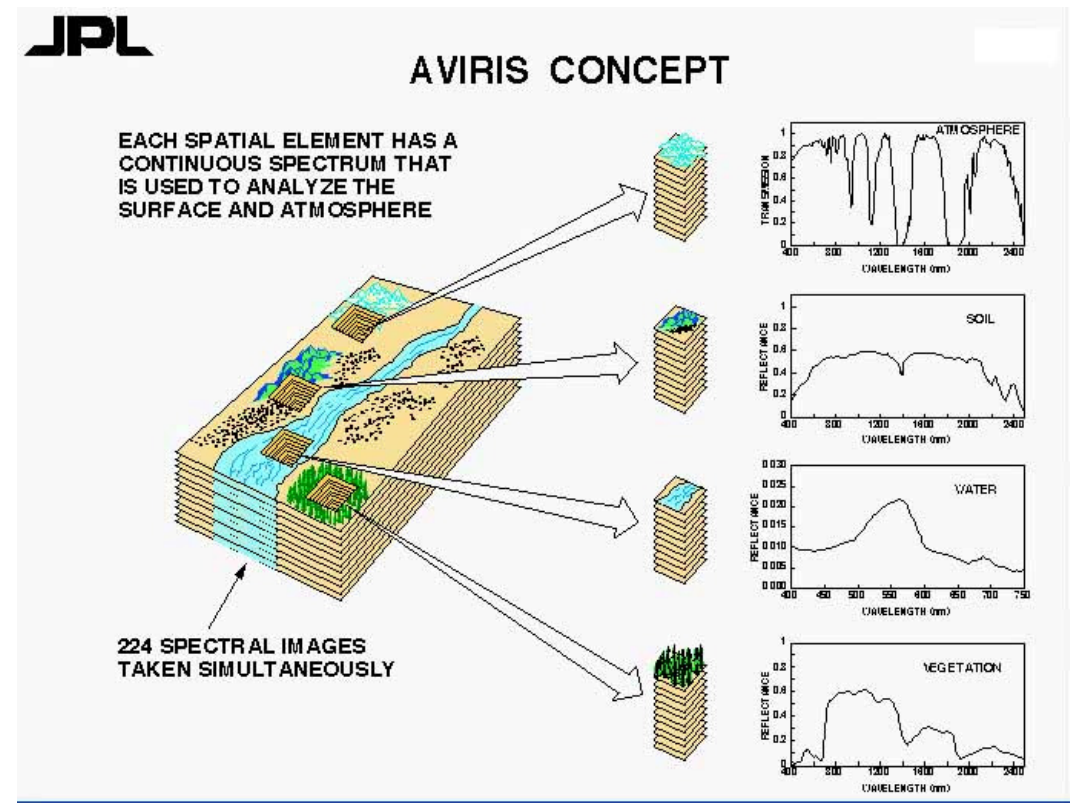
Figure 10. The NASA Advanced Visible Infrared Imaging Spectrometer (AVIRIS) has been at the forefront of the development of imaging spectroscopy